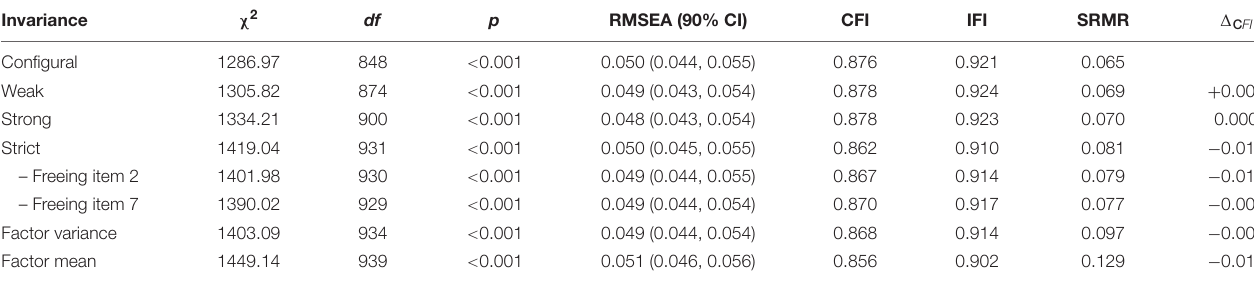
TABLE 5 | Measurement and structural invariance of the SRL-SRS for Sport Practice among elite ( n = 288) and non-elite ( n = 127)